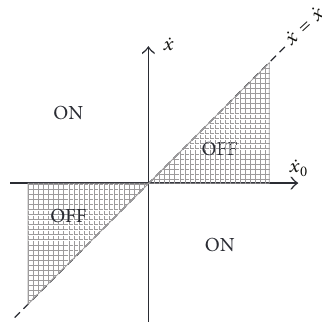
Figure 9: States of the MR dampers according to the velocity of the frame and of the ground, following the sky-hook control